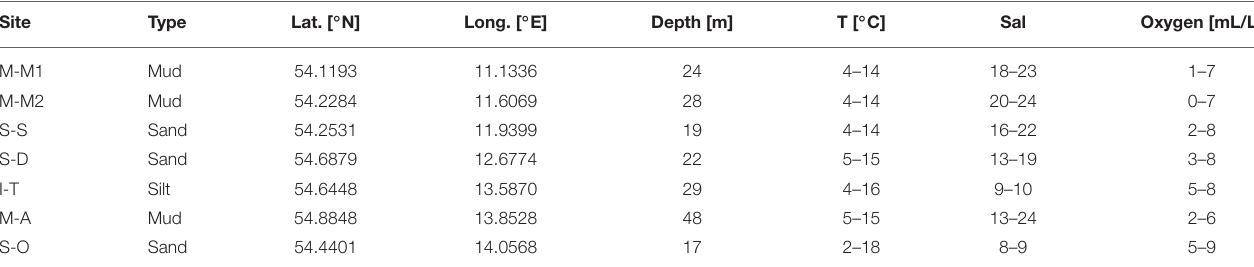
TABLE 1 | Sampling sites, their sediment types and typical bottom water temperature, salinity and oxygen concentration investigated in the present